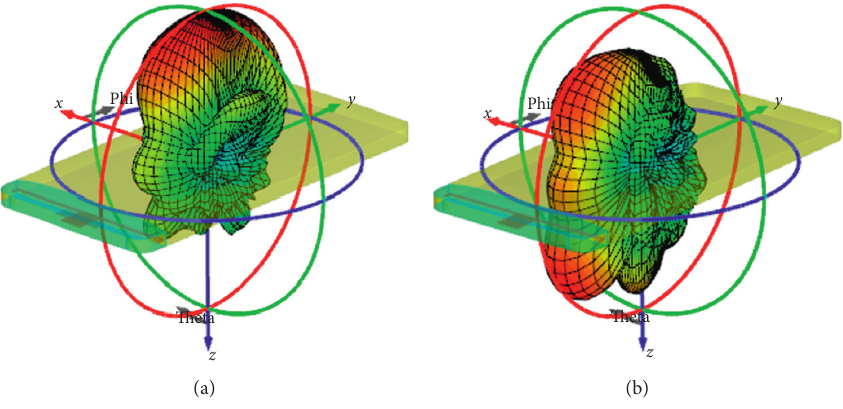
Figure 14: CST’s point density: (a) PBS in the form factor; (b) MBS in the form factor.